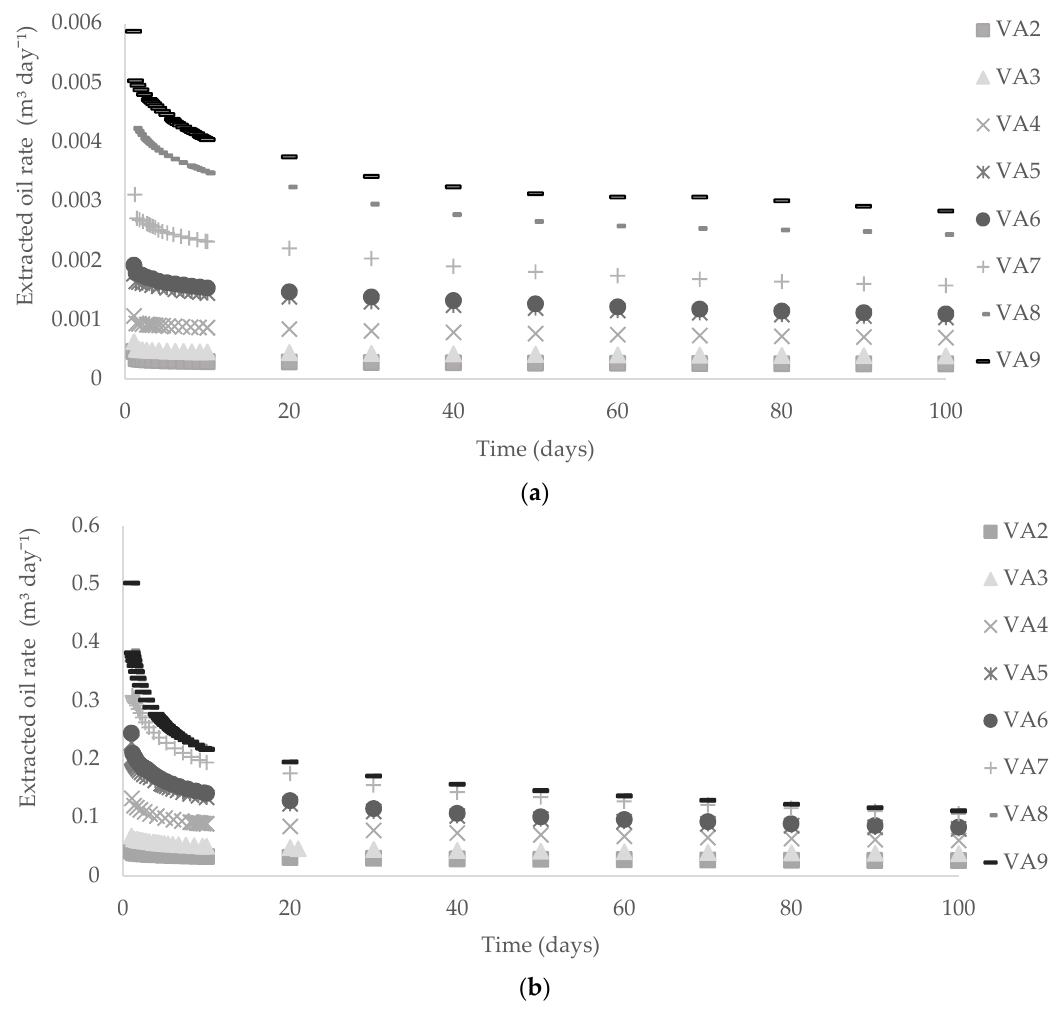
Figure 6. Oil extraction rate over time in 100 days of simulation using di ff erent vacuum pressures ( a ) Silty sand, ( b ) Oxisol (VA2 = 1.33, VA3 = 2.66, VA4 = 6.00, VA5 = 11.33, VA6 = 12.40, VA7 = 24.93, VA8 = 49.86, and VA9 = 66.26 kPa).